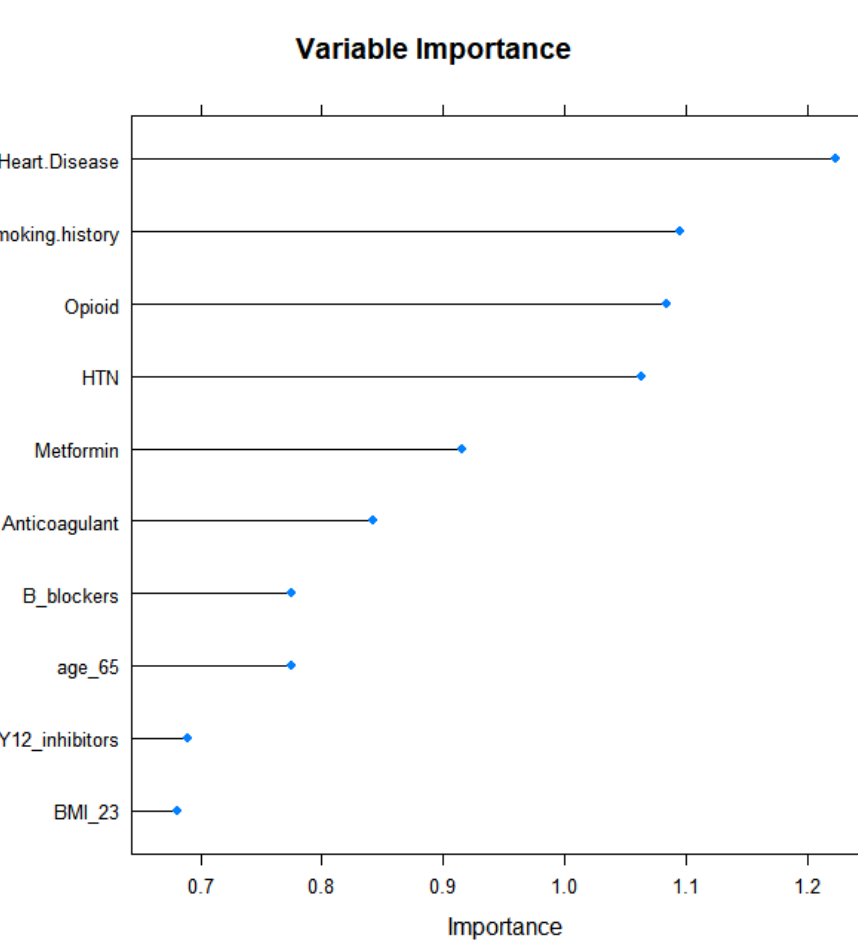
Figure 1. Top 10 variables by importance estimated using random forest to predict thyroid-related adverse events in patients with cancer receiving ICIs. Table 3. Comparisons of AUC for the logistic regression, elastic net, random forest, and SVM models.